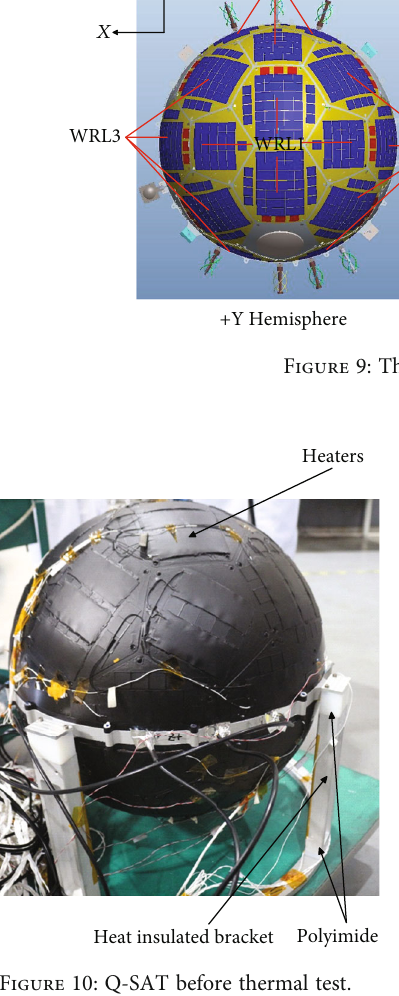
Figure 10: Q-SAT before thermal test.